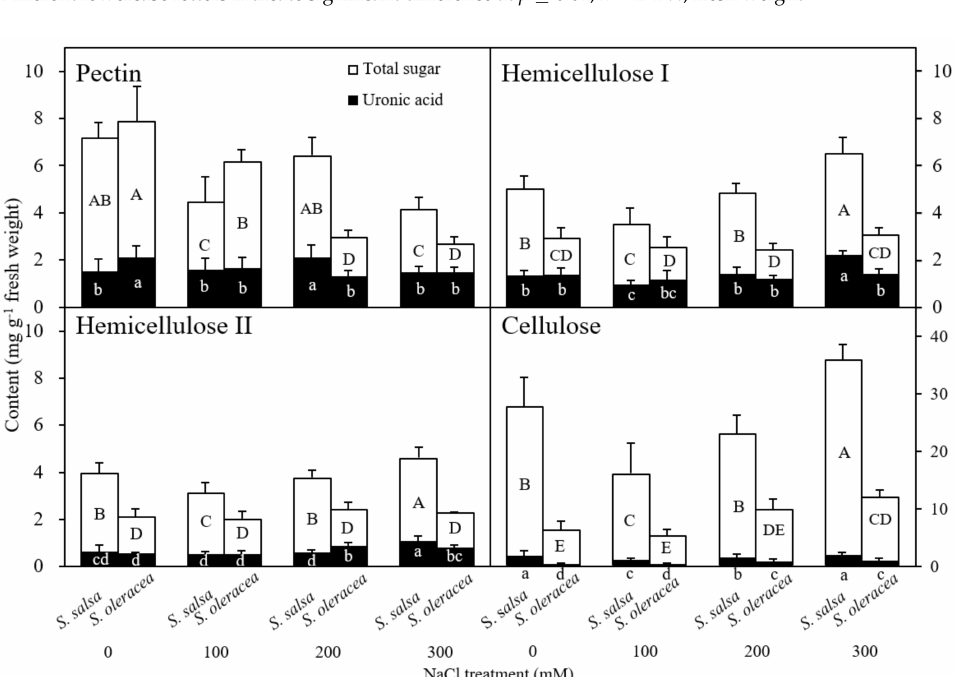
Figure 5. Total uronic acid-containing sugar and uronic acid content in the pectin, hemicellulose I, hemicellulose II, and cellulose cell wall fractions in the apical 0–5 mm region in S. salsa and S. oleracea roots grown under 0, 100, 200, and 300 mM NaCl treatments. Data are mean + S.D. ( n = 4). Different uppercase (total sugar) and lowercase (uronic acid) letters indicate significant differences ( p < 0.05). Results of the correlation analysis are shown in Tables 2 and 3. Hemicellulose I and hemicellulose II contents, including the uronic acid within them, were negatively correlated with root growth in S. salsa . In contrast, there was a positive correlation between pectin content and root growth in S. oleracea , while cellulose content was negatively correlated with root length in both species. Similarly, there was a positive correlation between the uronic acid content in pectin and root length in S. oleracea , but not in S. salsa . Furthermore, the uronic acid content in cellulose was negatively correlated to root length in both species. Lastly, pectin content in S. oleracea showed significant correlations with root length, cellulose content, and uronic acid content in pectin, hemicellulose II, and cellulose, whereas no such correlations were observed for S. salsa